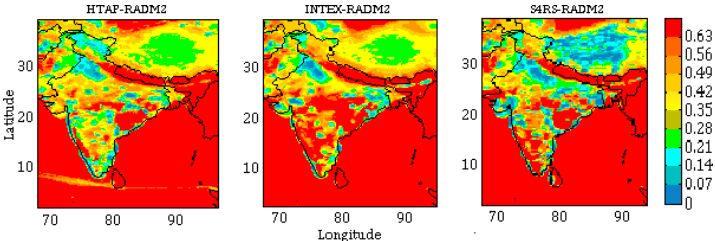
Figure 5. Net daytime surface CH 2 O to NO y ratio in simulations with different inventories for the month of April during